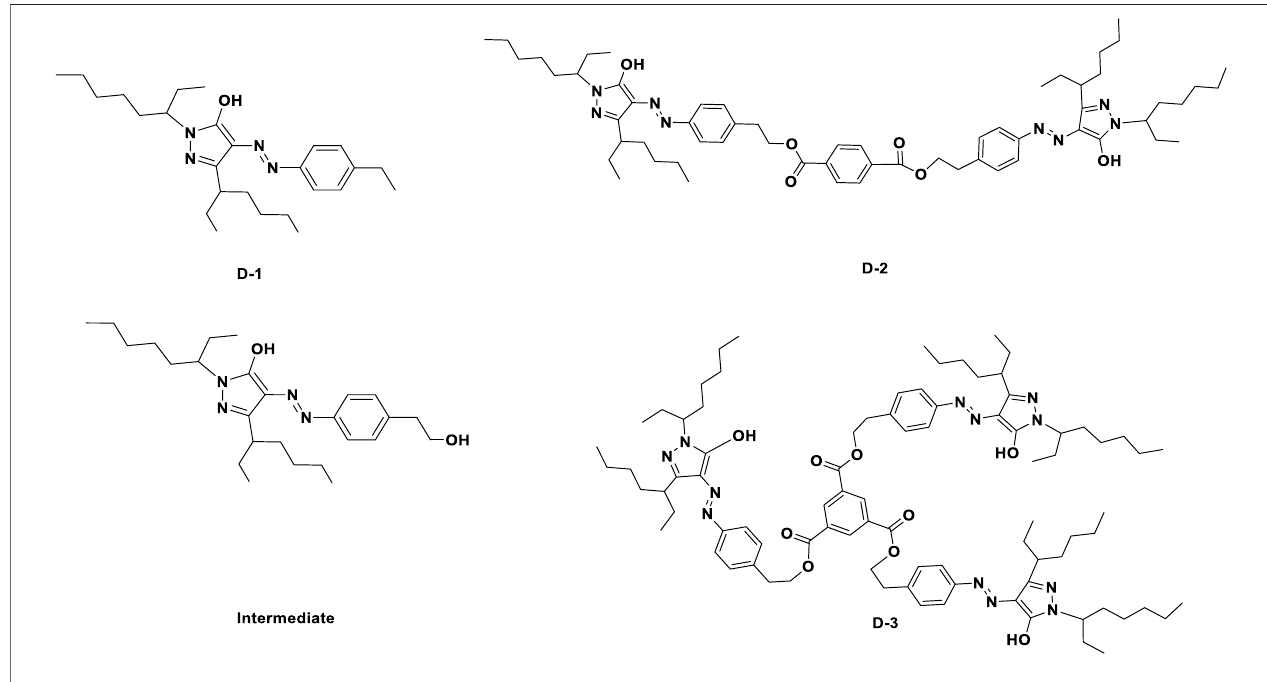
FIGURE 1 | Molecular structures of the Intermediate and three synthesized